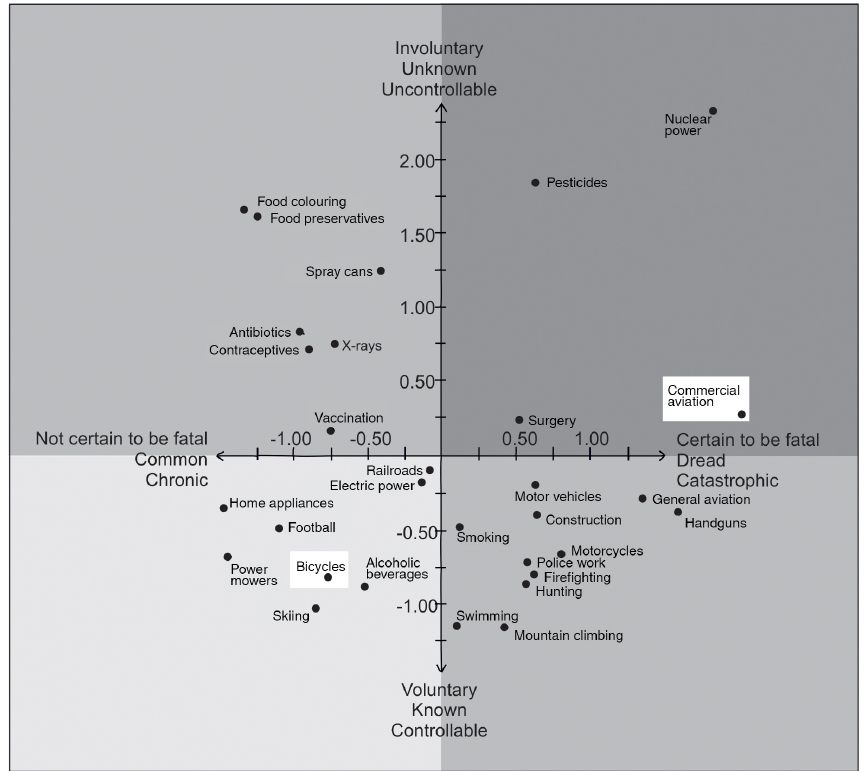
Figure 1. The perception of risk within a two-factor space, representing public perceptions of how risky an activity was based on its familiarity and how fatal the consequences may be (Slovic, 1987, p.